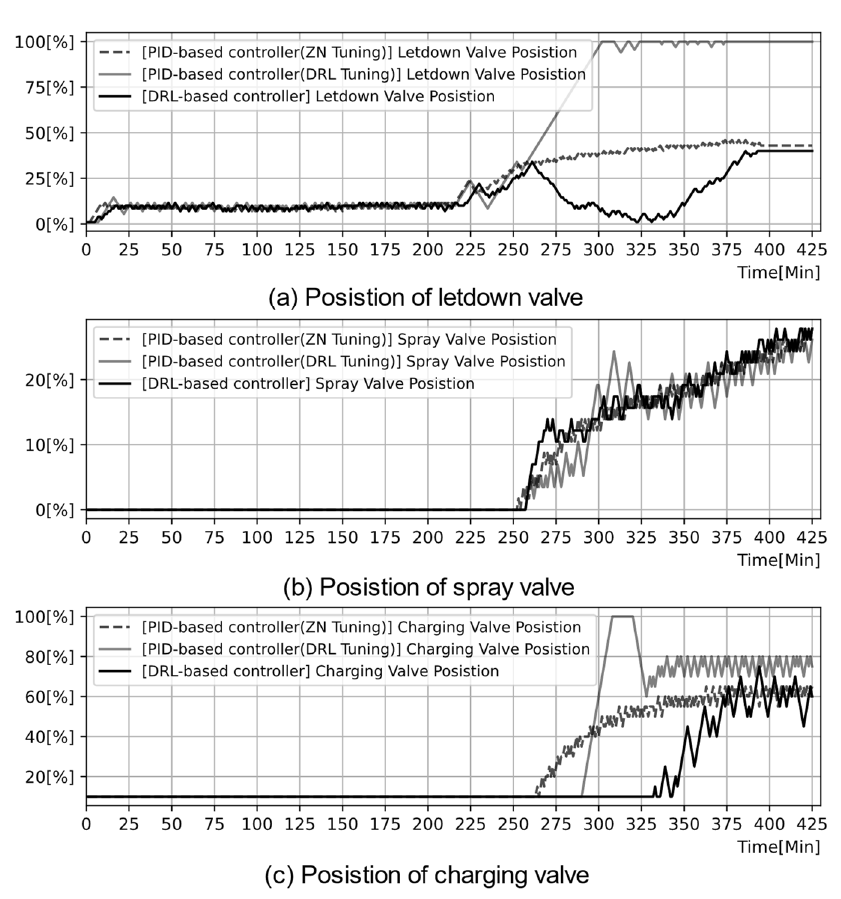
Figure 24. Positions of ( a ) letdown; ( b ) spray; ( c ) charging valve.